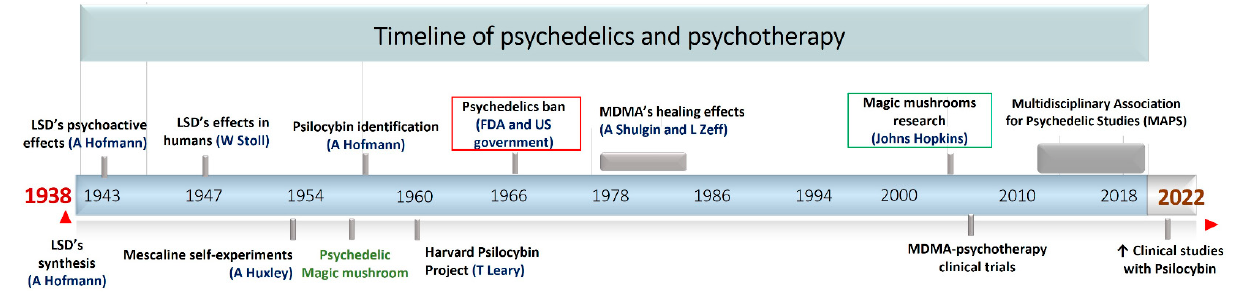
Figure 1. Timeline highlighting main historical events relating to the use of psychedelics in psycho- therapy.